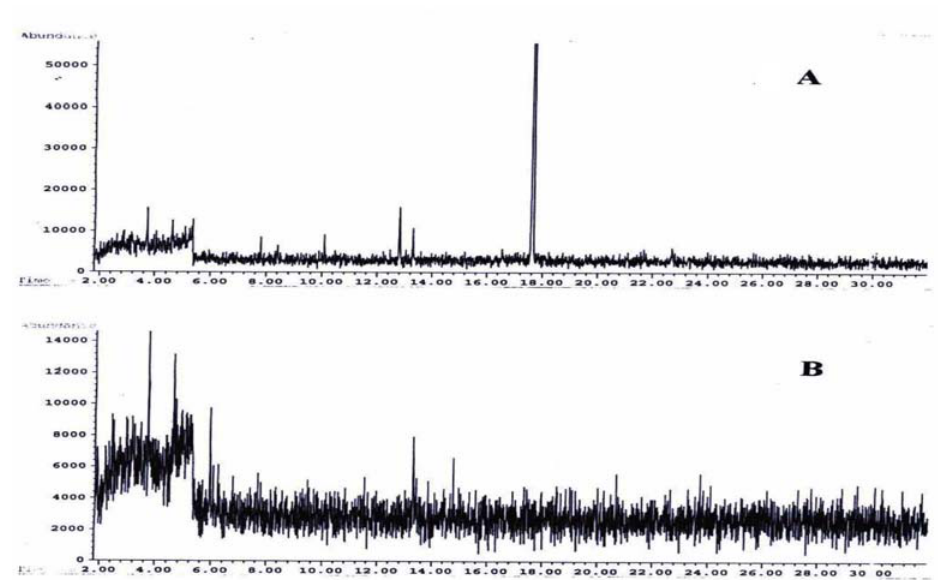
FIGURE 3 . Comparison of total ion chromatograms of air samples collected outdoors (A) and indoors (B) in Tedlar bags, preconcentration volume 75